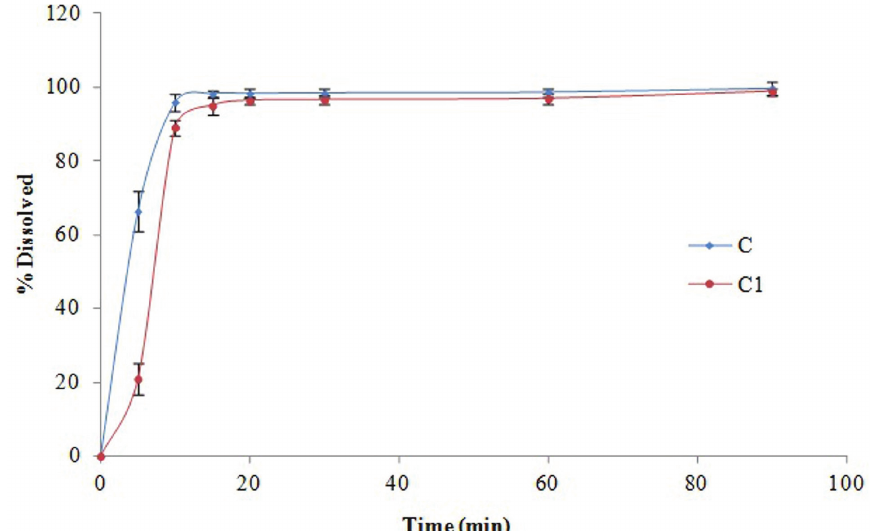
FIGURE 3 - Dissolution profiles of the pellets obtained in C and